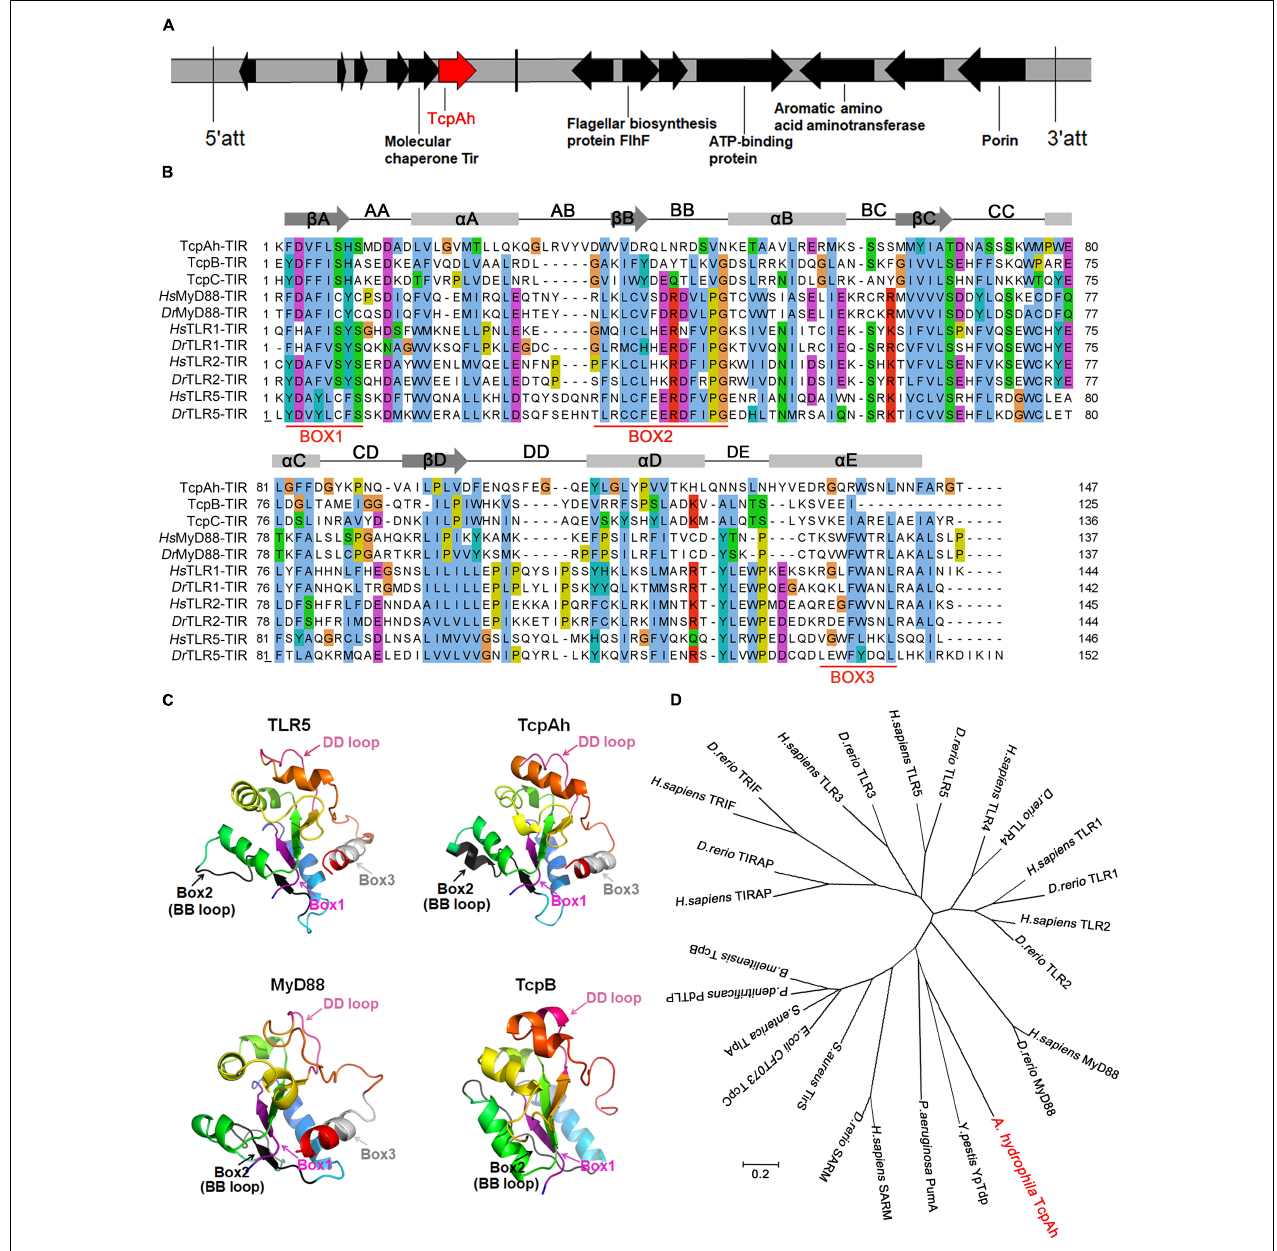
FIGURE 1 | Bioinformatic characterization of TcpAh-encoding gene and protein in A . hydrophila JBN2301 strain. (A) Localization of TcpAh-encoding gene in JBN2301 genome. The encoding sequence of TcpAh is indicated in red arrow and att means attachment site. (B) Sequence alignment of TIR domains using Jalview/ClustalW and ClustalX programs. Conserved functional motifs and amino acid residues are shaded in different colors. Secondary structures were predicted by Jalview/Jpred program. Gray boxes, gray arrows, and black lines denote alpha helices, beta-sheet areas, and connecting loops, respectively. (C) Prediction of the 3D structures of TIR domains using Phyre server and PyMol program. The TcpAh TIR domain (38–184 aa) was modeled with 100% confidence by the single highest scoring template as the TIR domain of TLR5 (PDB c3j0aA). Box 1 (purple), box 2 and BB loop (black), and box 3 and DD loop (hot pink) are indicated within the TIR domains. (D) Phylogenetic trees of the amino acid sequences of TcpAh and its homologs in other species constructed by neighbor-joining method using MEGA 7.0. The tree was drawn to scale, and branch lengths are in the same units as those of the evolutionary distances used to infer the phylogenetic tree. The evolutionary distances were computed using the p-distance method. The GenBank accession numbers of the sequences are as follows: H . sapiens MyD88, AAC50954.1; D . rerio MyD88, AAQ91324.1; H . sapiens TLR1, NP_891549.1; D. rerio TLR1, AAI63271.1; H . sapiens TLR2, AAY85648.1; D . rerio TLR2, NP_997977.1; H . sapiens TLR3, NP_003256.1; D . rerio TLR3, AAI07956.1; H . sapiens TLR4, NP_003257.1; D . rerio TLR4, NP_001315534.1; H . sapiens TLR5, NP_003259.2; D . rerio TLR5, NP_001124067.2; H . sapiens TRIF, AAH09860.2; D . rerio TRIF, NP_001038224.1; H . sapiens TRIAP, NP_001034750.1; D . rerio TRIAP, XP_002667158.2; H . sapiens SARM, NP_055892.2; D . rerio SARM, NP_001124068.1; Y . pestis YpTdp, WP_198249346.1; A . hydrophila TcpAh, WP_043158960; P . aeruginosa PumA, WP_012075302.1; S . aureus TirS, WP_000114516.1; E . coli CFT073 TcpC, WP_000282336.1; S . enterica TlpA, WP_079786625.1; P . denitrificans PdTLP, QAR27511.1; B . melitensis TcpB,